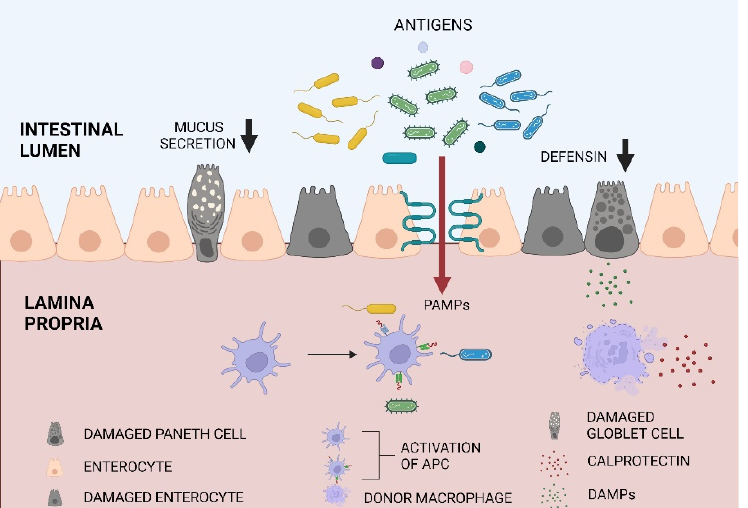
Figure 1. Intestinal barrier disruption after allo-HCT. Pre-transplant conditioning results in enterocyte, goblet cells and Paneth cells apoptosis. Increased MLCK expression results in loosening of the tight junctions and PAMPS translocation into the lamina propria. PAMPS (e.g., LPS) and DAMPs from damaged cells activate APCs. It results in donor T cell activation, pro-inflammatory cytokines i.e., IFN- γ , TNF- α , IL-5 release and GVHD initiation. This figure was created with BioRender. MLCK; myosin light chain kinase, PAMPs; pathogen-associated molecular patterns, LPS; lipopolysaccharide, DAMPs; damage-associated molecular patterns, APC; antigen- presenting cell, IFN- γ ; interferon gamma, TNF- α ; tumor necrosis factor alpha, IL-5; inter- leukin 5, GVHD; graft-versus-host